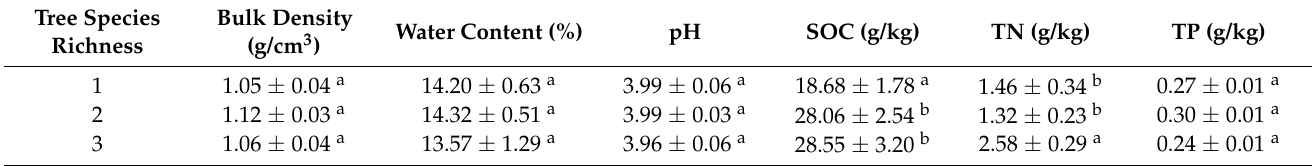
Table 2. Soil physical and chemical properties in tree clusters varying in tree species richness, from one, two, and three tree species combinations. Tree